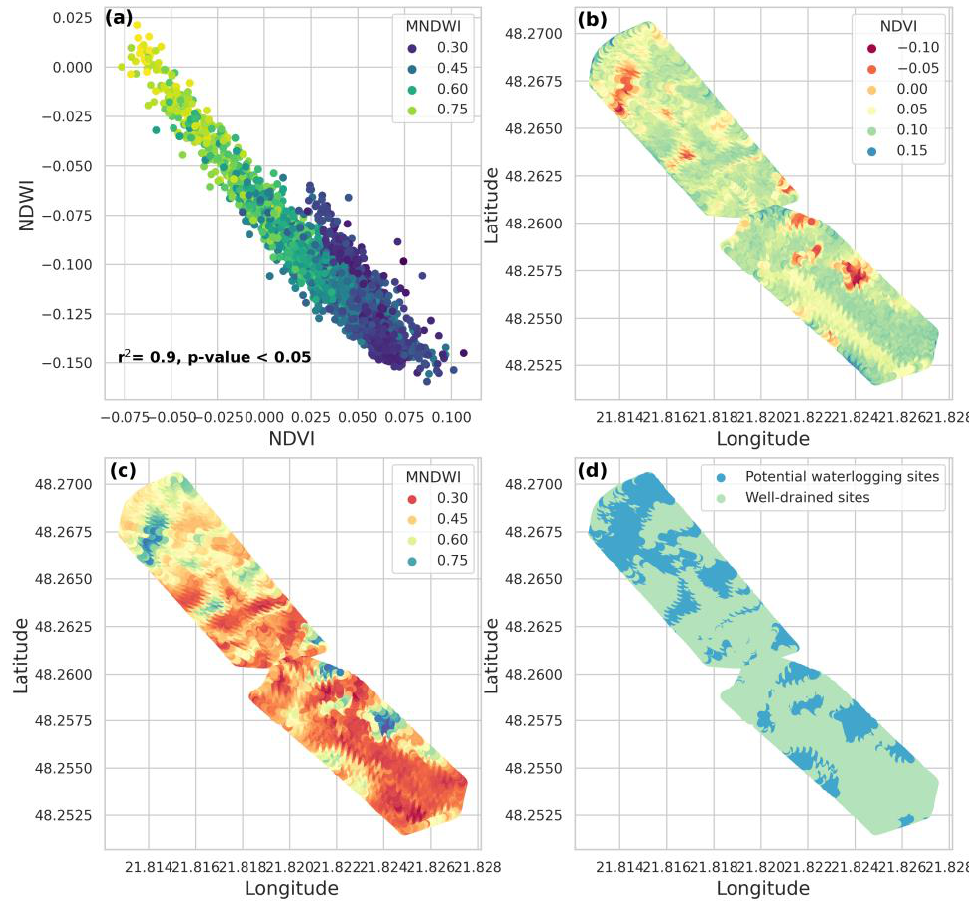
Figure 2. Spatial distribution of vegetation and water indices used to detect waterlogging patterns in the investigated field. ( a ) Relationship between NDVI, NDWI, and MNDWI. Note the strong negative correlation between NDVI and the two water indices. ( b ) Spatial patterns of NDVI. ( c ) Spatial distribution of MNDWI for the investigated field. The dark blue color indicates high values of MNDWI and potential waterlogging sites. ( d ) Map of waterlogging detected across the field, using a combination of water and vegetation indices and the K-means algorithm.